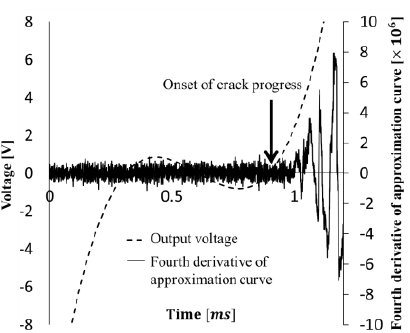
Fig. 3 Time history of output voltage at 147s -1 by DC potential difference method and the fourth-derivative of approximated curve